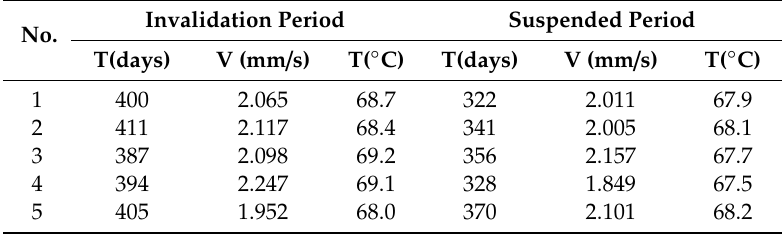
Table 5. Invalidation period and the suspended period for an OWT